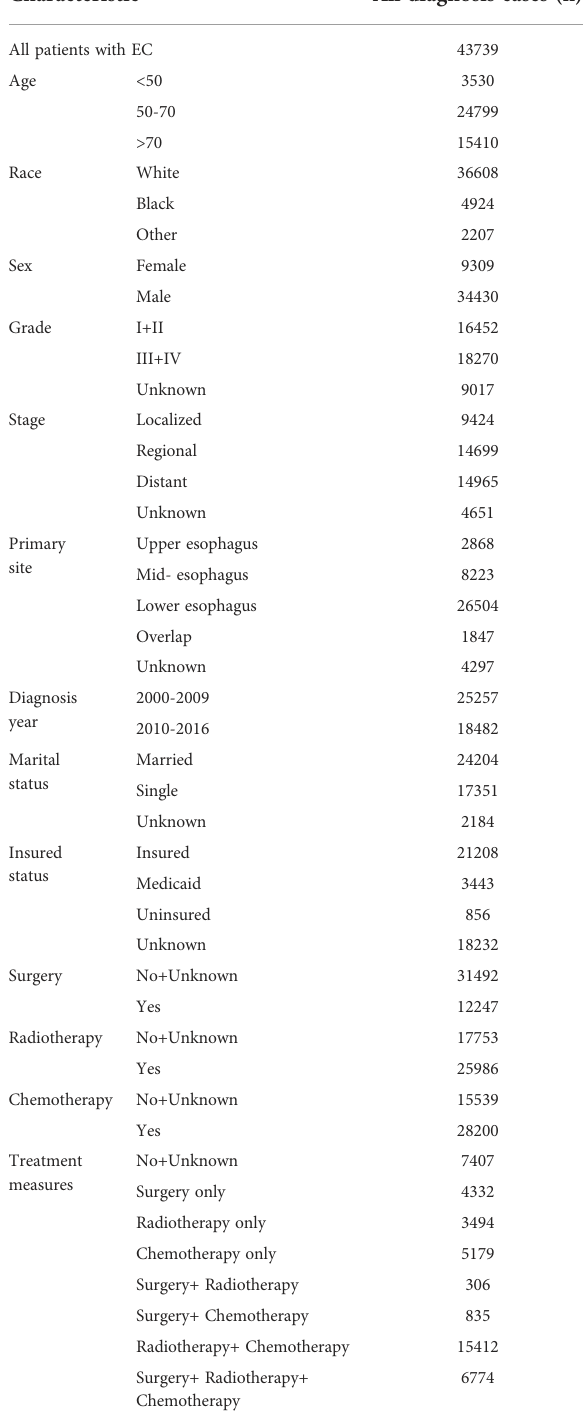
TABLE 1 Baseline characteristics of EC